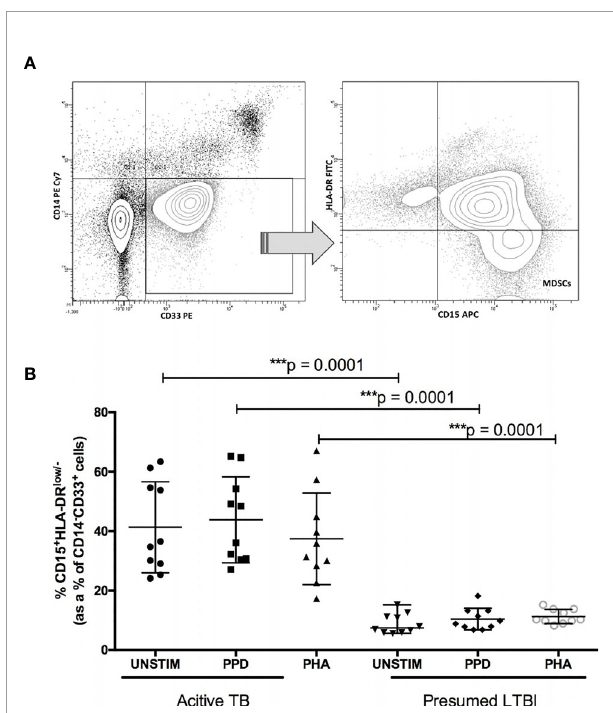
FIGURE 1 | Frequency of myeloid derived suppressor cells (MDSC) in the peripheral blood compartment of participants with presumed-latent infection and active TB. (A) Flow cytometry gating strategy. Cells were fi rst gated on CD14 - CD33 + cells, and within this population HLA DR low/- CD15 + cells were identi fi ed. (B) frequency of CD14 - CD33 + HLA-DR low/- CD15 + MDSCs before and after stimulation with PPD and PHA. p-value of <0.05 were considered signi fi cant (Mann-Whitney unpaired t-test). ***p-value